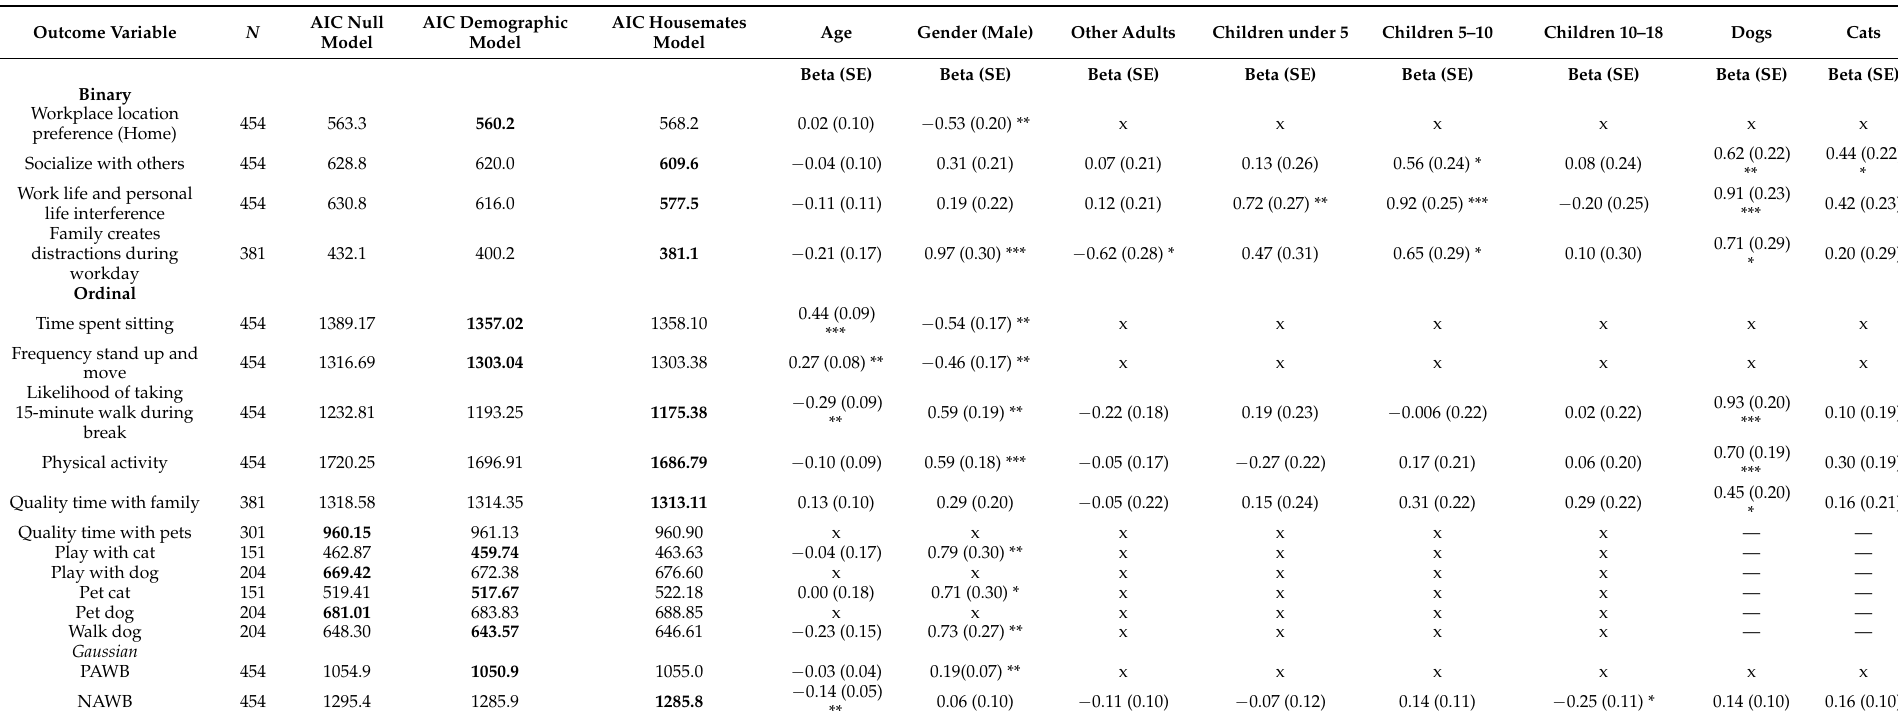
Table 2. Regressions on outcome variables regarding the experience of working from home. Betas and standard errors are only included for covariates that were part of the final model. Bolded Akaike information criterion (AIC) values indicate which model was